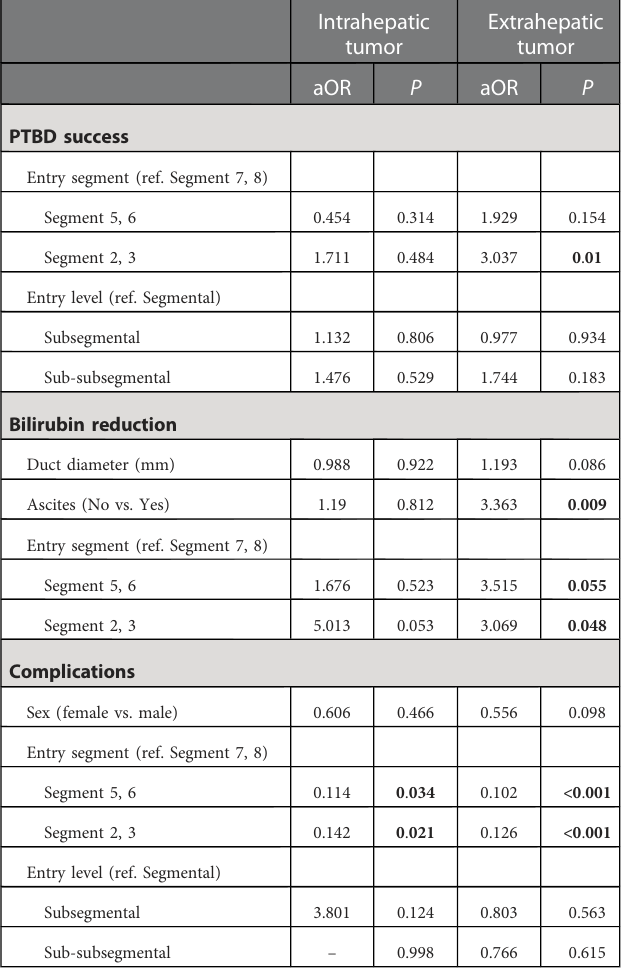
TABLE 4 Adjusted association of intrahepatic/extrahepatic tumors with PTBD success, bilirubin reduction, and complications. Intrahepatic